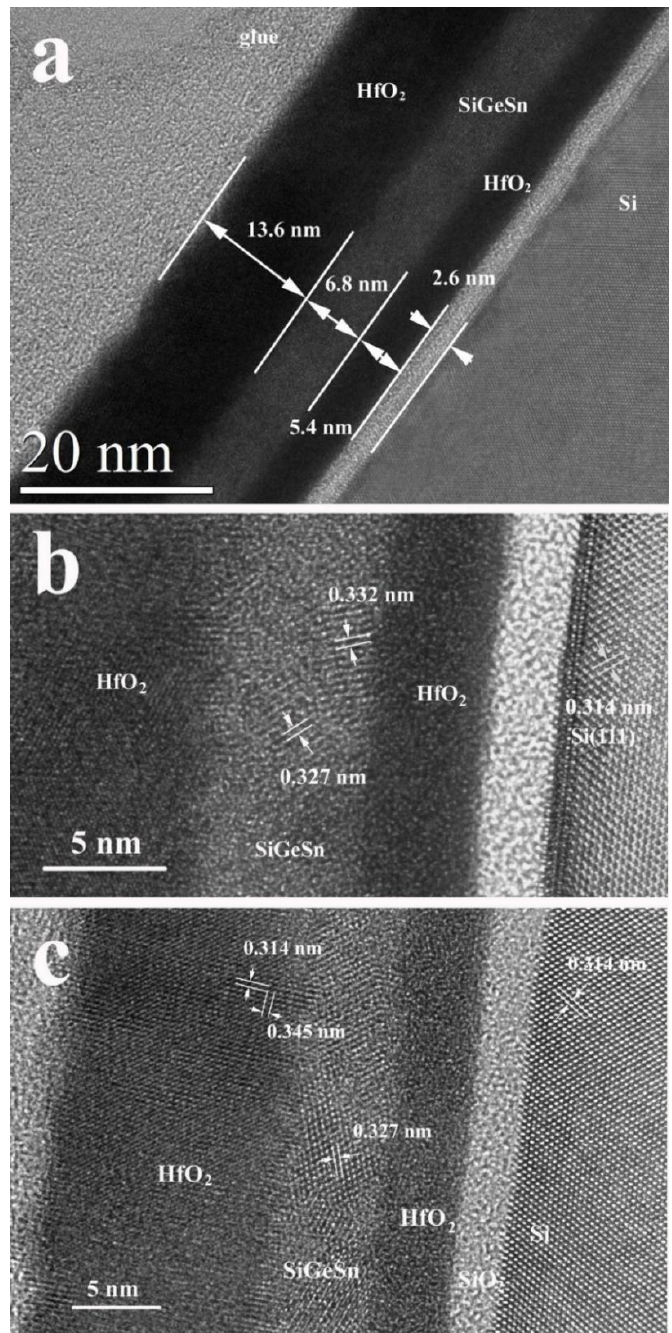
Figure 1. XTEM results on structure M1-530-10: ( a ) low magnification cross-section TEM image revealing the thicknesses of component layers in the 3-layer stack structure; ( b ) HRTEM image evidenc- ing lattice fringes d 111 = 0.327 nm very close to pure Ge plane spacing (0.326 nm) in the floating gate , and d 111 = 0.332 nm at the interface of floating gate with adjacent layers , respectively (with 0.314 nm (111) lattice distance measured in the Si substrate as the reference); ( c ) HRTEM image showing the monoclinic crystalline structure of HfO 2 (e.g., 0.314 nm fringe) in the gate oxide layer , the amorphous structure in the tunnel layer , and a 5 nm SiGeSn crystallite in [110] orientation in the floating gate